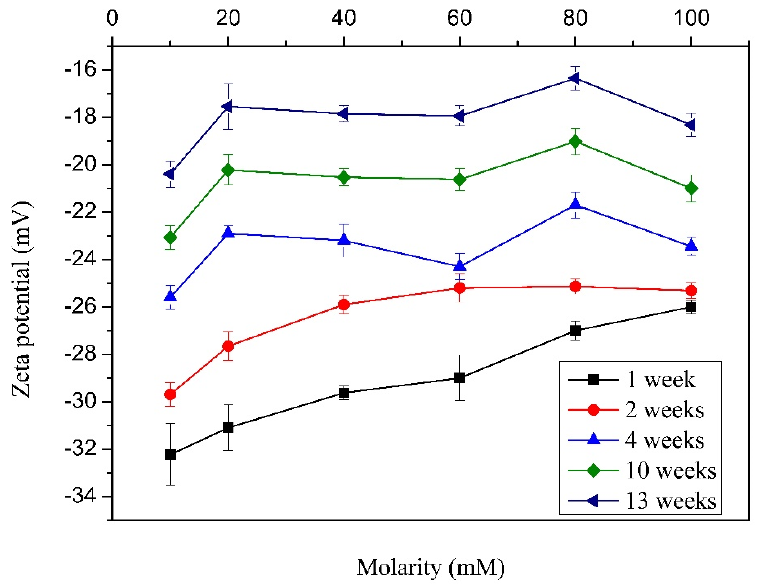
Figure 6. Z-potential of MWCNT dispersions in water with different TX-100 molarities and weeks of Figure 6. Z ‐ potential of MWCNT dispersions in water with different TX ‐ 100 molarities and weeks of storage.